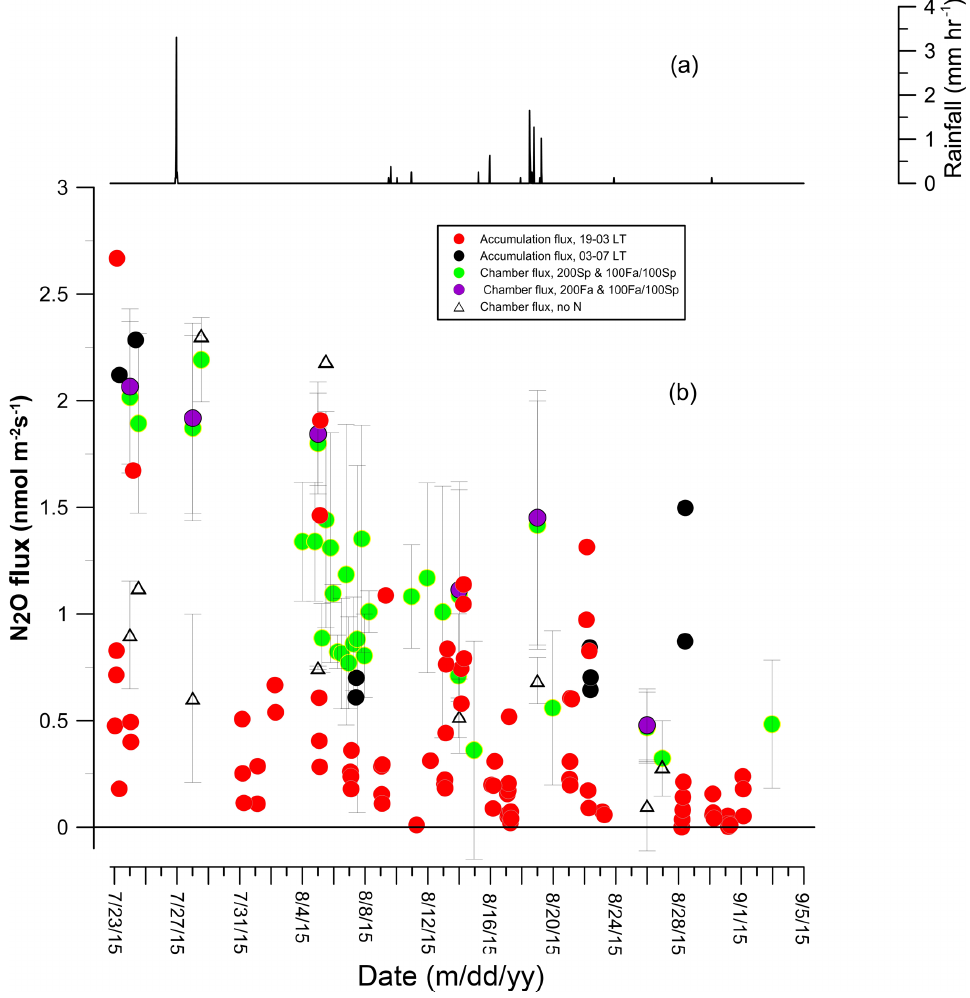
Figure 8. Precipitation and N 2 O flux based on accumulation and chamber methods. Precipitation is indicated in panel (a) . Total fluxes (accumulative within and diffusive out the top of the control volume) under stable, low turbulence conditions and soil + root fluxes calculated using the chamber method are indicated in panel (b) (ordinate axis with differing units to left and right). The standard deviation of the three chamber flux measurements in each field is indicated by the vertical